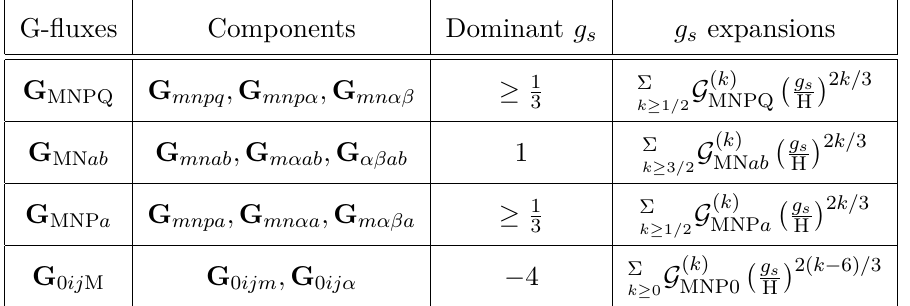
Table 2 . The g s scalings and expansions of the various G-flux components supporting the metric configuration (4.5). These G-flux components will also enter the perturbative quantum terms in (4.8). All the G-flux components G ( k ) ( y ) depend on the coordinates of M 4 × M 2 and N 1 N 2 N 3 N 4 k ∈ Z . The numbers in the third column provide the dominant g s scalings of the flux 2 H